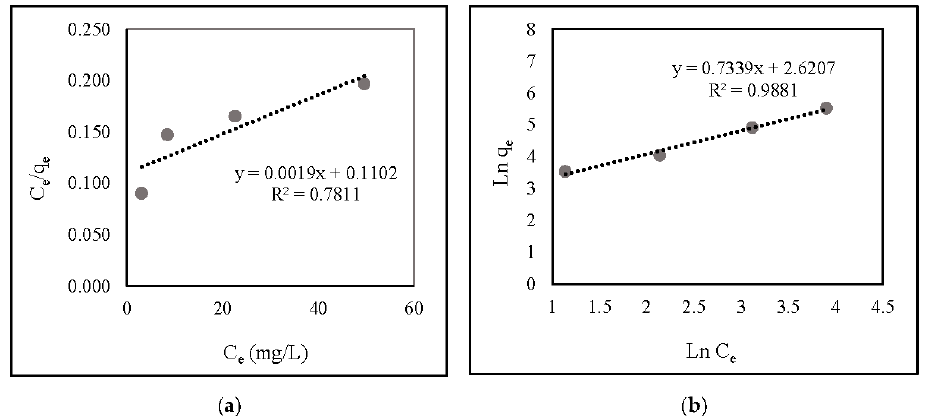
Figure 6. Linear isotherm plot of nitrate adsorption onto ZLCH-Fe; ( a ) Langmuir model; ( b ) Freun- dlich model.